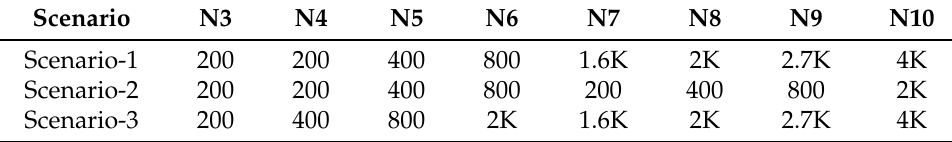
Table 4. Data rate of each node (bps).